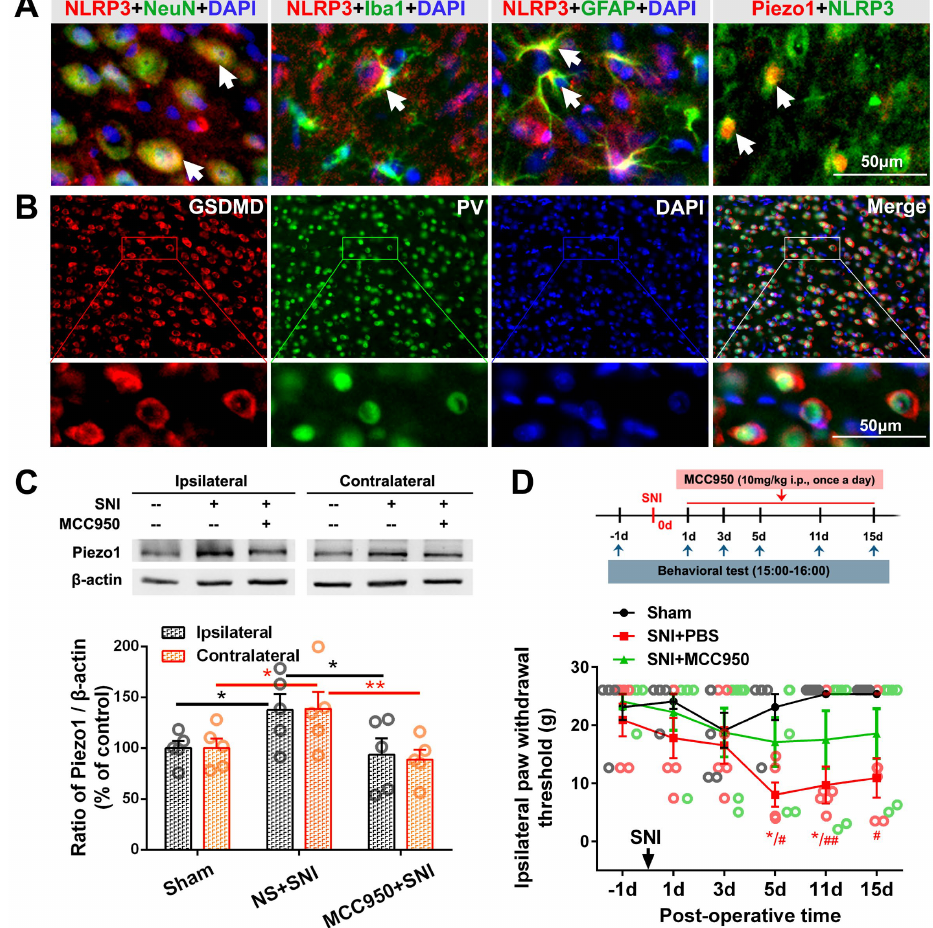
Figure 7. The effect of NLRP3 inhibition on SNI-induced Piezo1 upregulation and pain behavior. ( A ) Representative double staining showing the overlap of NLRP3-IR (red) with NeuN, Iba1 and GFAP (green), 7 d after SNI. NLRP3-IR (green) also colocalized with Piezo1-IR neurons (red). White arrow shows the co-localization (yellow). Scale bar = 50 μm. ( B ) Representative double immunofluorescence staining image showing the encapsulation of PV-IR by GSDMD-IR, a pore-forming protein downstream to NLRP3 inflammasome. Scale bar = 50 μm. Blue fluorescence in (A and B) is from DAPI. ( C ) Representative Western blot showing the effect of the NLRP3 inhibitor MCC950 (10 mg/kg i.p., once a day for 7 days) on the Piezo1 protein level in the bilateral ACC (top). Protein quantification results (bottom). * p- value < 0.05, ** p- value < 0.01 (two-way ANOVA). ( D ) Changes in ipsilateral paw withdrawal thresholds in sham, SNI + PBS, and SNI + MCC950 group. Significant differences in the threshold were observed in SNI + PBS rats but not SNI + MCC950 rats compared with sham rats on PO days 5, 11 and 15 ( n = 6). * p- value < 0.05 versus PO day − 1 (Dunn’s multiple comparisons test) or # p- value < 0.05, ## p- value < 0.01 versus the sham group (multiple t test).